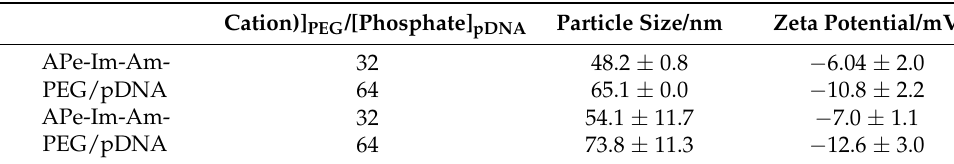
Figure 2. The pDNA MIC formation with APe-Im-Am-PEG or APe-Im-Es-PEG assessed by agarose gel electrophoresis. The mixing charge ratios of the ω -amide-pentylimidazolium group of APe-Im-Am-PEG or APe-Im-Es-PEG to phosphate group of pDNA ([ ω -amide-pentylimidazolium (Cation)] PEG /[Phosphate] pDNA ) (+/ − ) are indicated. The solid arrowhead indicates the well where each sample was loaded. The migration band of super-coiled pDNA is indicated by “sc”. Table 1. Particle size and zeta potential of APe-Im-Am-PEG and APe-Im-Es-PEG